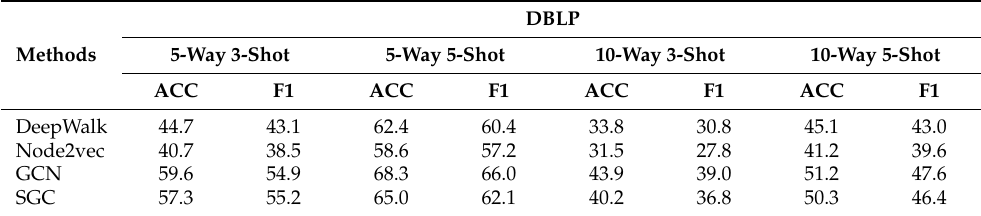
Table 3. The few-shot node classification ACC and F1 results on DBLP.